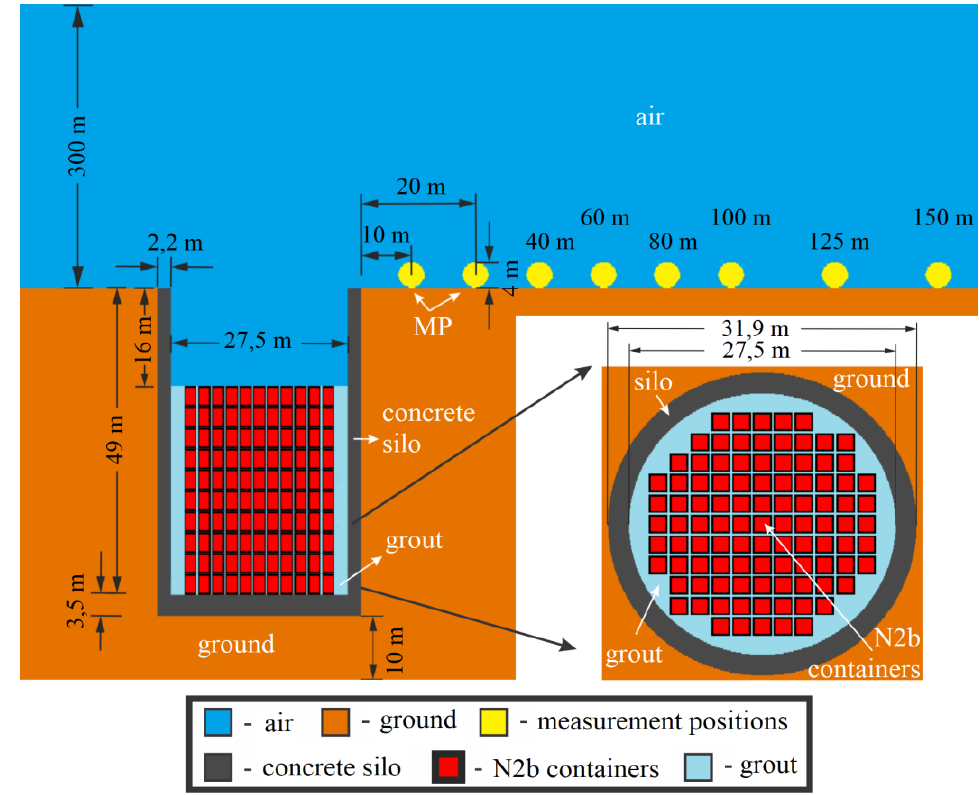
Figure. 1. Schematic view of the computational model of the LILW repository, side view (left) and top view (right). Due to clarity, four measurement positions are not visible (MP: 30 m, 50 m, 70 m and 90 m). (drawing not to